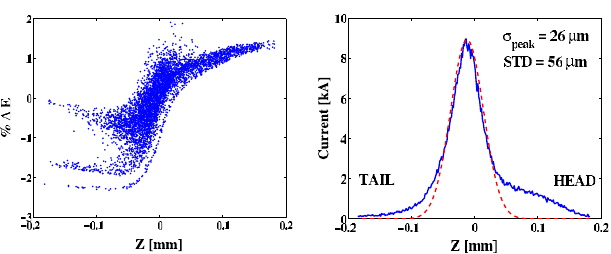
FIG. 2. (Color) (A) An example of the incoming beam’s phase space according to LITRACK simulations. (B) Longitudinal charge profile of the incoming beam obtained by the projection of the phase space from (A). The mathematical standard devia- tion of the entire distribution is 56 (cid:2) m and the standard devia- tion of the central Gaussian-shaped distribution, plotted with the dashed line, is 26 (cid:2) m .